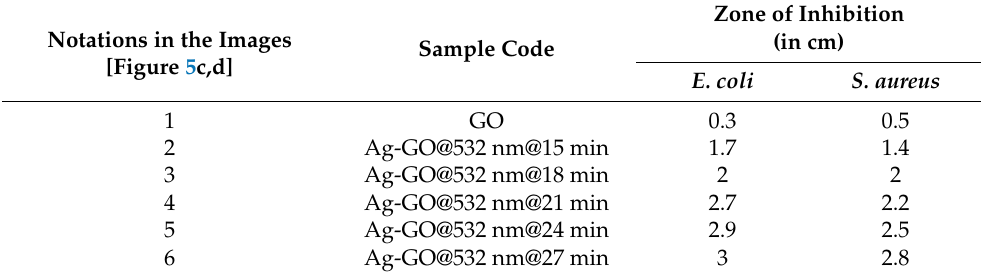
Table 2. Inhibition zone diameters of E. coli and S. aureus bacteria treated with Ag-GO@532 nm samples synthesized at different time